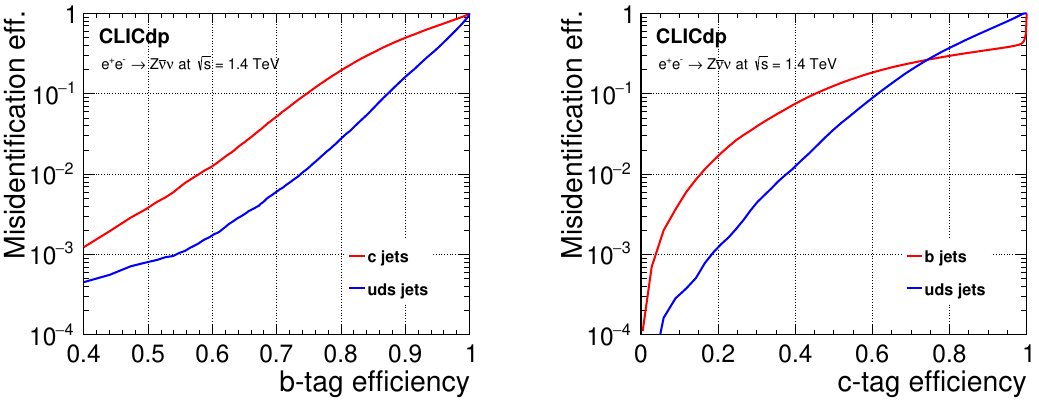
Figure 6. Flavour tagging performance in e + e (cid:0) ! Z nn events at 1.4 TeV reconstructed in the CLIC ILD detector. The fake rates for jets of other (cid:13)avours are shown functions of the b-tag (left) and c-tag (right) e(cid:14)ciencies.